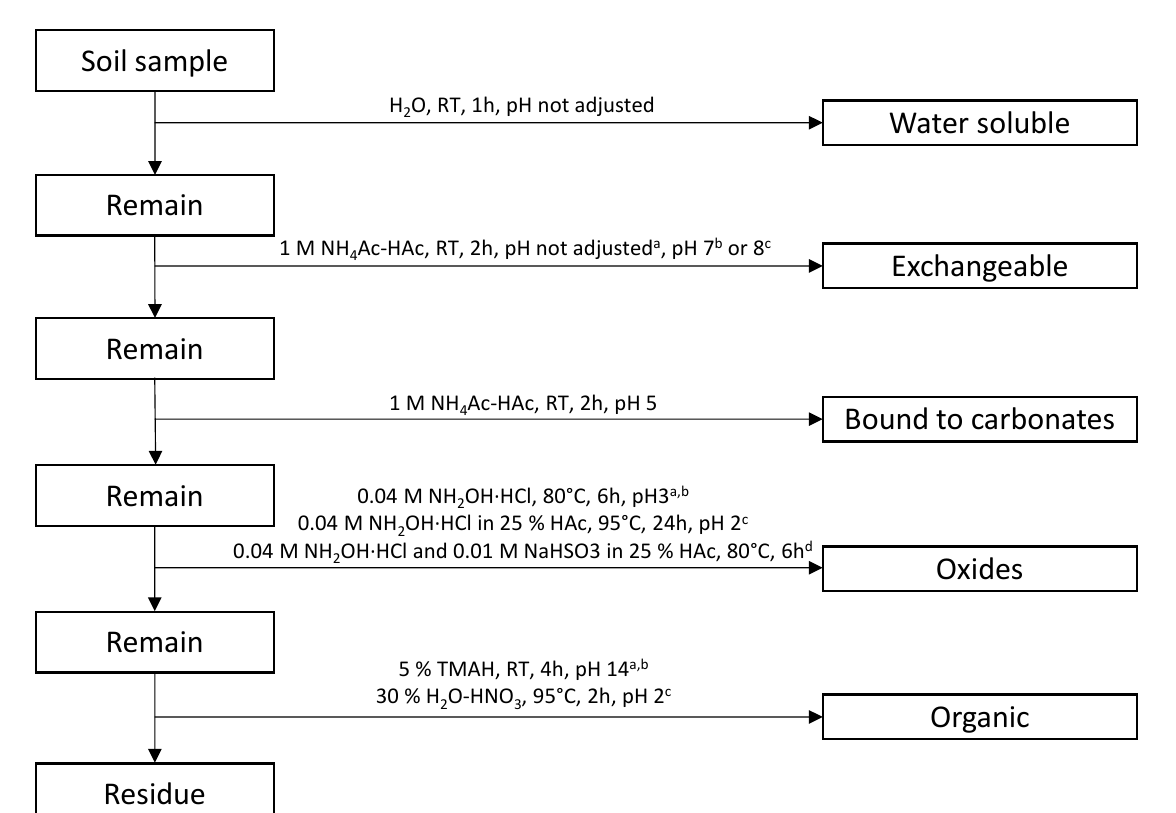
Figure 3. Extracting agents and conditions used for iodine fractionation from soil in selected studies. RT—room temperature; TMAH—tetramethylammoniumhydroxide, a [33], b [34], c [68], d [65] . Table 1. Distribution of iodine in each soil fraction